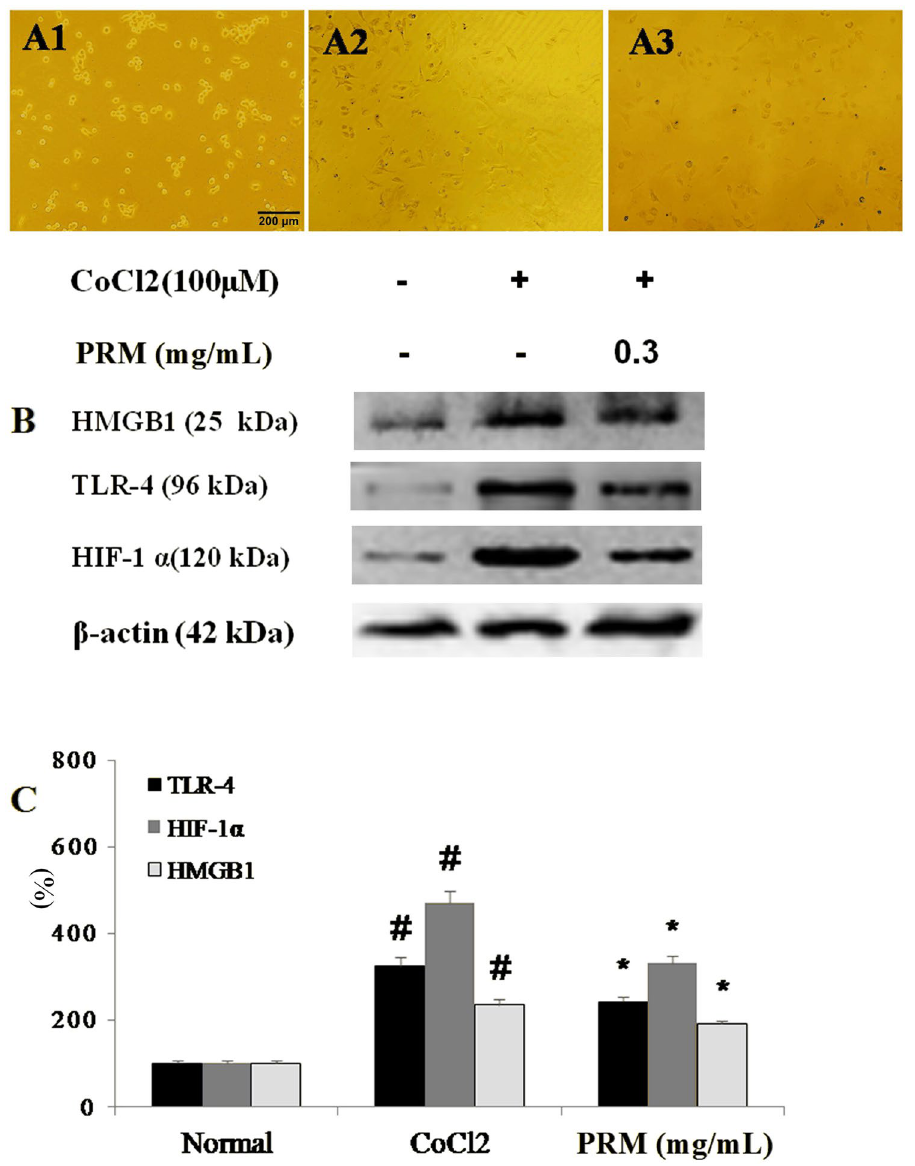
Figure 2. Effects of PRM on EMT in A549 cells. ( A ) Representative light microscopic appearance of A549 cells of normal A549 cells (A1), CoCl 2 -treated A549 cells (A2), and cells treated with CoCl 2 + 0.3 mg/mL PRM (A3). ( B,C ) A549 cells were incubated with CoCl 2 (100 μ M) for 48 h. HMGB1, TLR-4 and HIF-1 α expression was analyzed by western blot. The results are reported as percent increase over the normal. Data are reported as the mean ± S.D., n = 5. # P < 0.01 vs. the normal group; * P < 0.05, ** P < 0.01 vs . the CoCl 2 stimulated